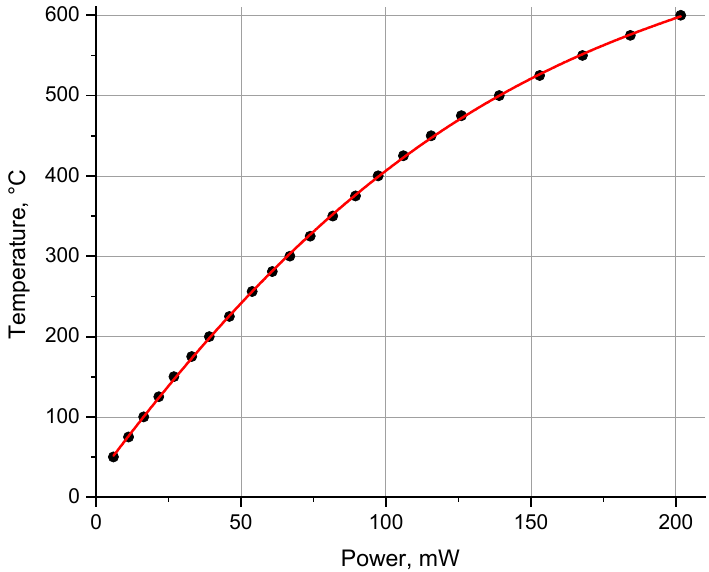
Figure 15. Power dependence of the temperature of the hot part of the microheater.